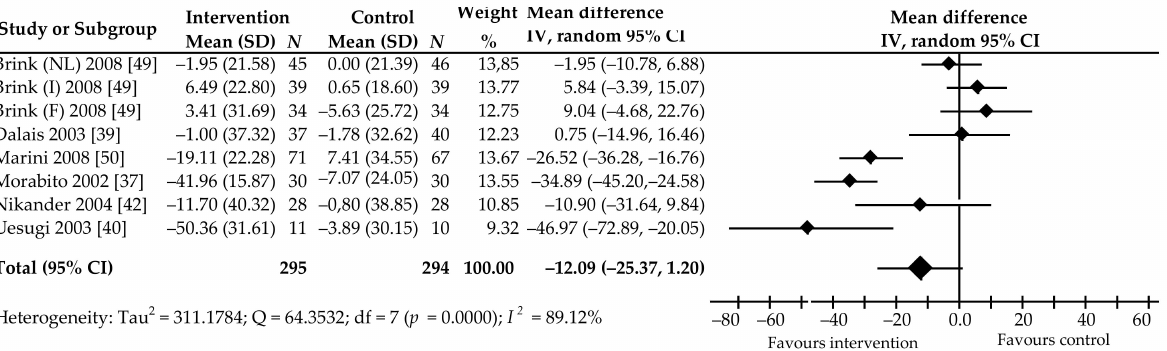
Figure 6. Percentage change in urine PYD values associated with intake of soy isoflavones compared with placebo. Note: abbreviations in parentheses following the author’s name indicate the name of the countries in which the research was conducted (NL, Netherlands; I, Italy; F, France); data calculated from the random-effects model are presented as weighted mean difference; IV, inverse variance; df, degrees of freedom; the horizontal lines denote the 95% CIs. We also analyzed the effects of soy Isof supplementation at a daily dose of